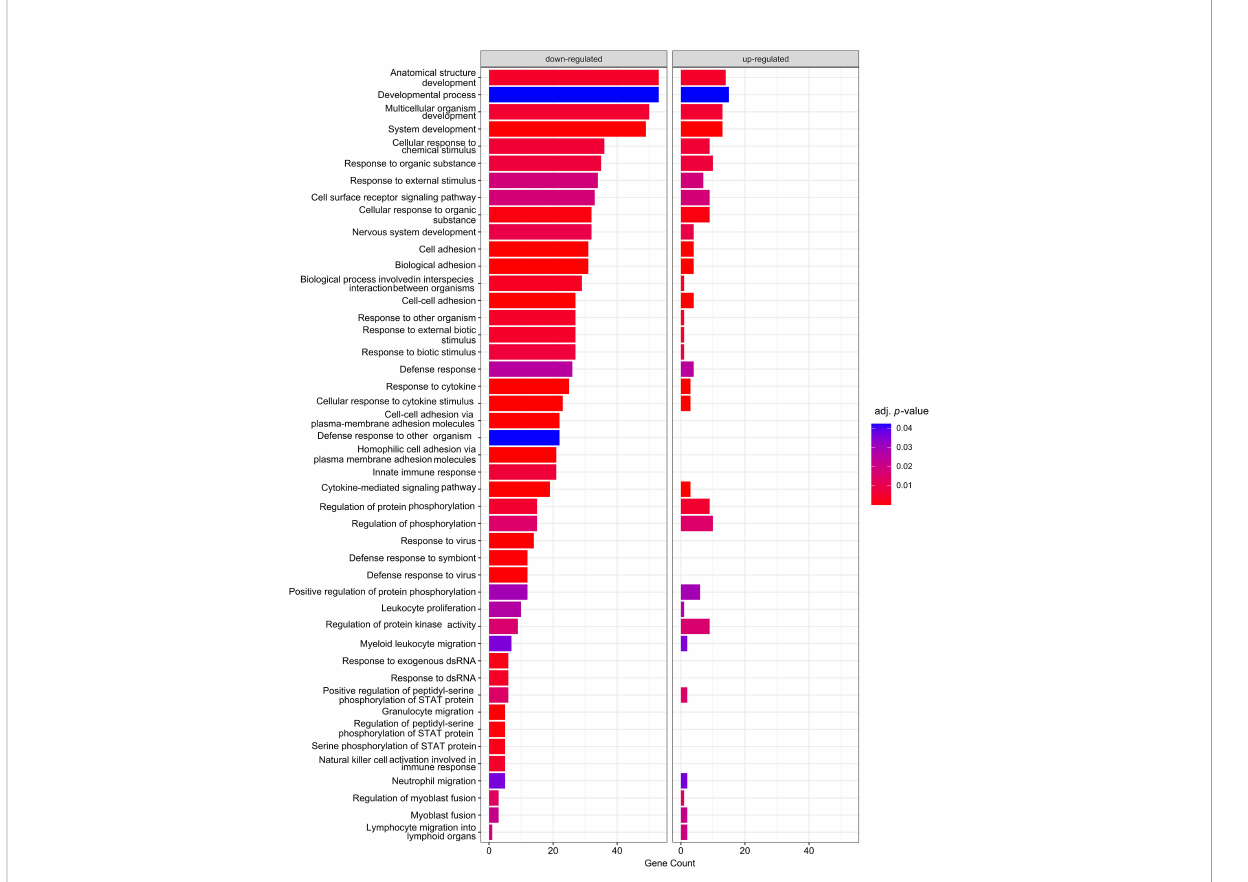
FIGURE 4 Enrichment analysis of DEGs according to GO: BPs. Analysis was carried out by comparison of S protein – expressing macrophage-like cells to the mock control. Size of the bars represent the genes enriched in a given term, and the colour corresponds of the adjusted p-value of the